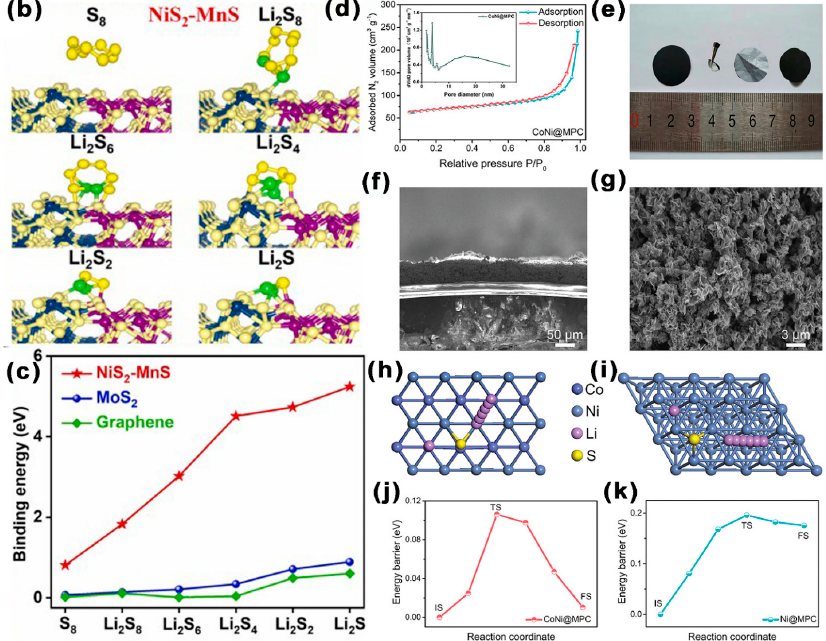
Figure 19. ( a ) Schematic diagram of the preparation of NiS 2 -MnS/MoS 2 -3DNGr. ( b ) Optimized atomic structures of NiS 2 -MnS with S species. ( c ) Binding energies for the S species and NiS-MnS [145]. ( d ) N 2 adsorption/desorption isotherm of CoNi@MPC, ( e ) Optical photograph of the CoNi@MPC-optimized separator before and after folding. ( f , g ) SEM images of the CoNi@MPC- optimized separator. Decomposition pathways of Li 2 S on ( h ) CoNi (111) and ( i ) Ni (111); energy curve of Li 2 S disintegration on ( j ) CoNi (111) and ( k ) Ni (111)